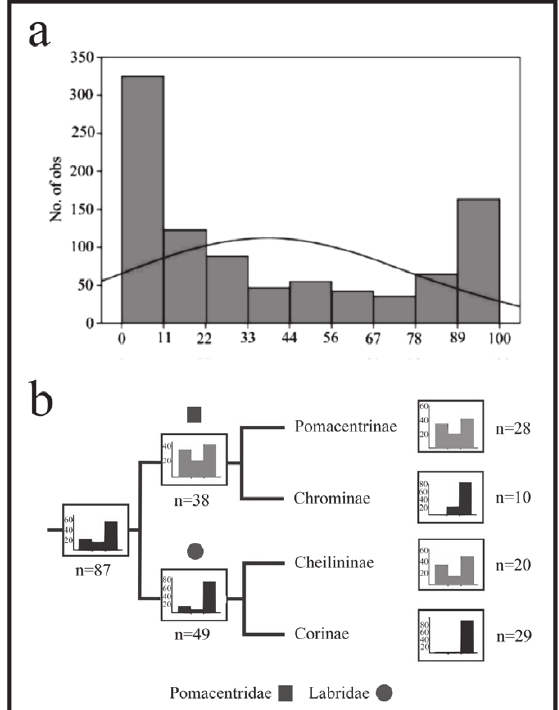
Figure 1 - Distribution of mono-brachial chromosome percentage in (a) karyotypes of 11 Actynopterigii Orders and (b) Pomacentridae and Labridae subfamilies. In (b), the first column corresponds to karyotypes with <33% acrocentrics, while the last column corresponds to karyotypes with > 66%